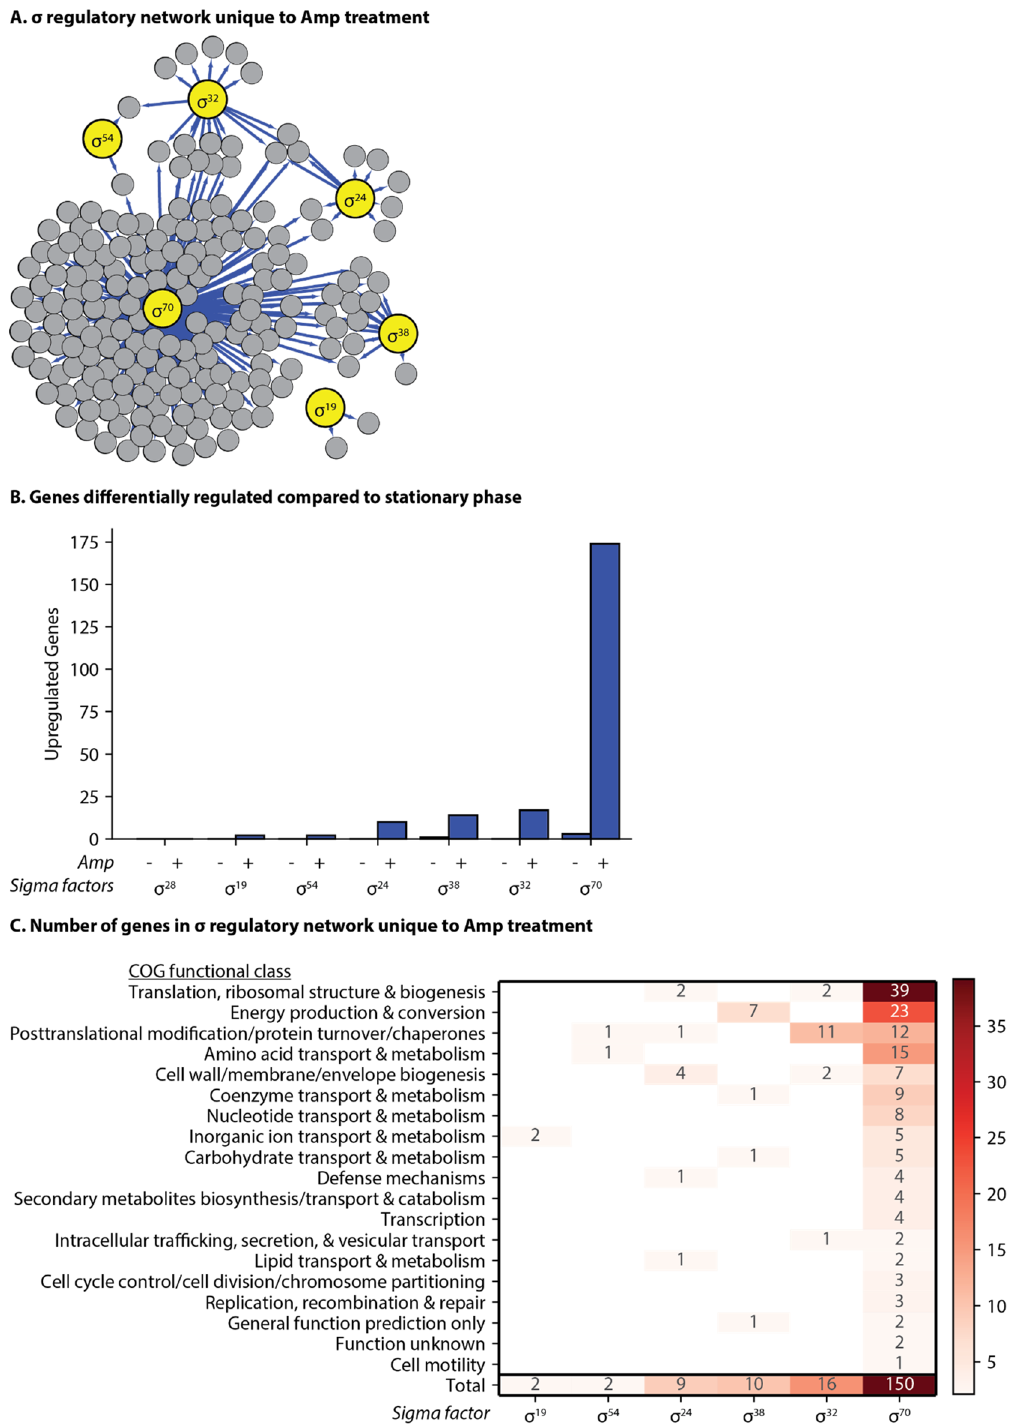
Figure 2. Stress related sigma factors (σ) are more active in the ampicillin treated population. Sigma factors act as global regulators that control several redundant and overlapping pathways related to antibiotic stress. Genes with increased expression over two-fold (adjusted p < 0.1) were mapped to sigma factors responsible for their transcription. ( A ) A graphical representation of the sigma regulatory network during antibiotic tolerance inferred from changes in gene expression unique to the ampicillin treated population compared to stationary phase (File S2). Blue lines: increased expression. Large yellow circles: sigma factors. Small grey circles: genes regulated by the sigma factors. ( B ) Counts of upregulated genes for the untreated and treated populations compared to stationary phase. Untreated (Amp−): cells incubated for 3 h in fresh media without ampicillin. Treated (Amp+): cells incubated for 3 h in fresh media with ampicillin. Genes with multiple possible sigma factors are accounted for each possible sigma factor. ( C ) Changes in gene expression for each sigma factor based on COG functional group; genes uncharacterized by REF 44 were not